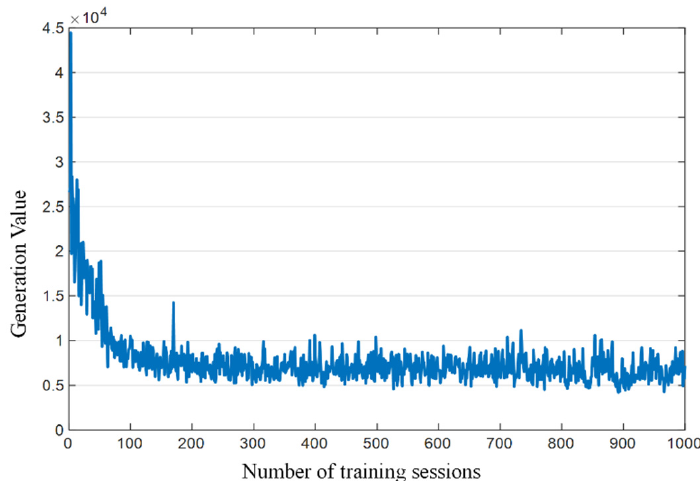
Figure 12. Generation value of the observation angle.